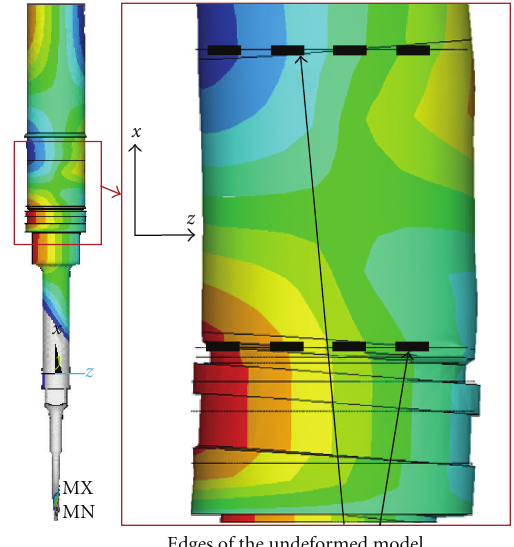
Figure 11: Deformation of the piezostack.